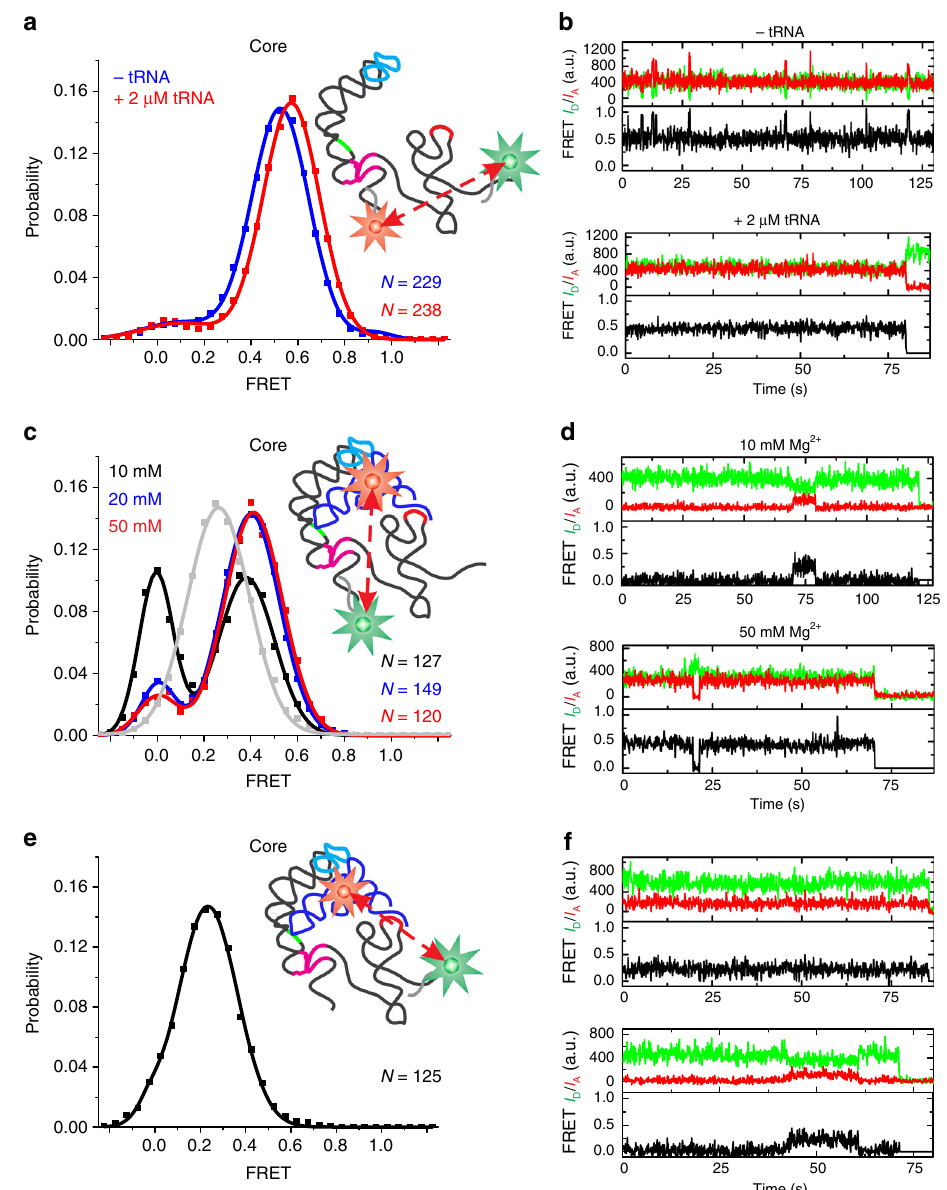
Fig. 3 smFRET analysis of tRNA binding to core T-box riboswitch. a FRET histograms and b exemplary traces for an smFRET measurement between the base of Stem-I and the base of antiterminator, in the presence and absence of unlabeled tRNA. c Histograms of smFRET measurements between tRNA and the base of Stem-I under different Mg 2 + concentrations. The gray curve shows the corresponding FRET histogram for the isolated Stem-I construct. d Example smFRET traces for measurement in c . e Histogram of smFRET measurement between tRNA and the base of antiterminator. f Example smFRET traces for measurement in